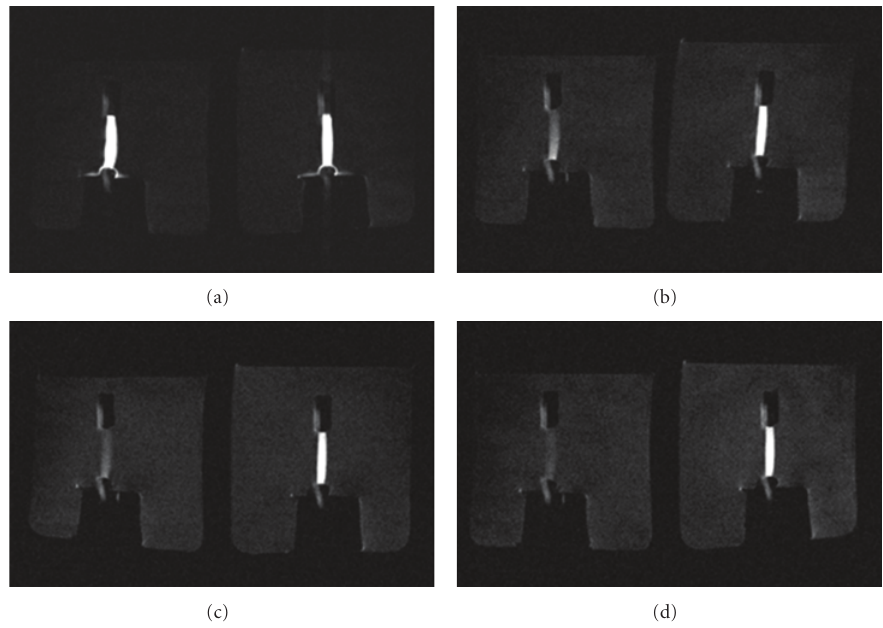
Figure 5: Magnetic resonance image montage of the progression of contrast media di ff usion through a dialysis cassette at t = 0, 329, 407, and 1489 minutes after injection, starting from top-left row, ending at bottom right. At 24 hours, the Gd DTPA-BMA (left fixture) has leaked out, while the HWO1-147 (right fixture) is relatively well-retained inside its cassette.